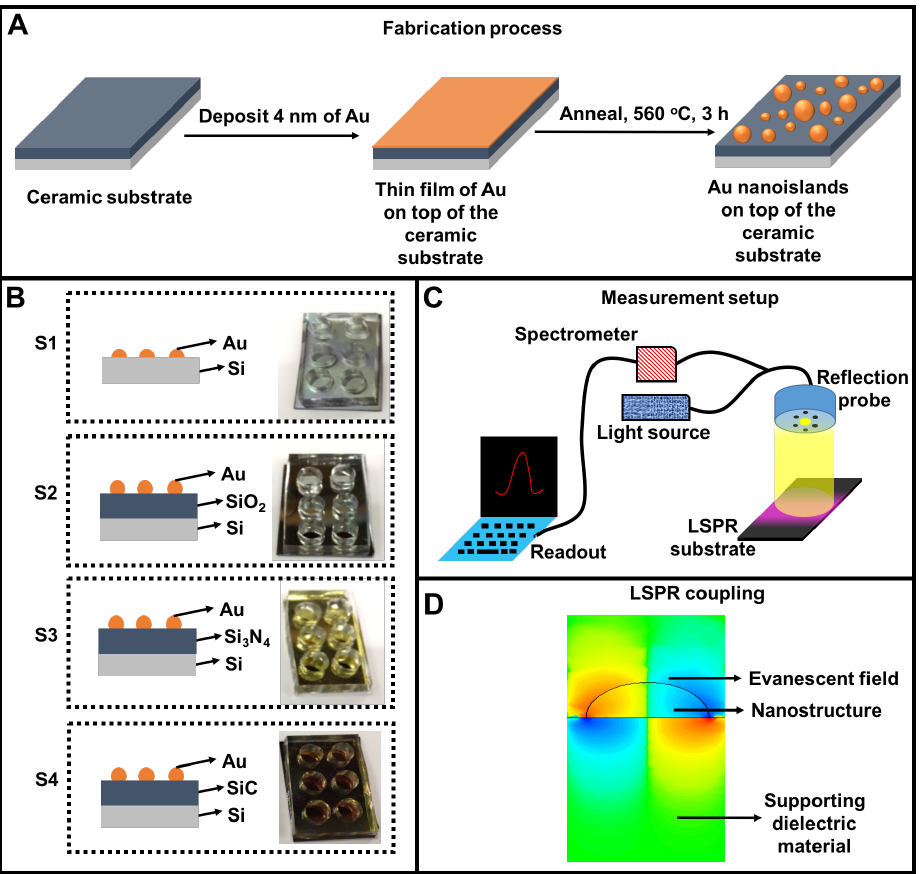
Figure 1. Fabrication and integration of the localized surface plasmon resonance (LSPR) chip and its measurement setup. ( A ) Two step nanoisland fabrication process where a thin film of Au is deposited on the ceramic substrate, followed by the dewetting of the Au film at high temperature. ( B ) Four types of LSPR chips where Au nanoislands are fabricated on four silicon-based ceramic substrates: silicon (S1), silicon dioxide (S2), silicon nitride (S3) and silicon carbide (SiC); ( C ) The LSPR measurement setup illustrates that LSPR wavelength shifts are acquired by the reflection of light from the top surface of the respective ceramic substrate; ( D ) Coupling of evanescent field in the supporting substrate. The strength of the coupling depends on the dielectric properties of the supporting